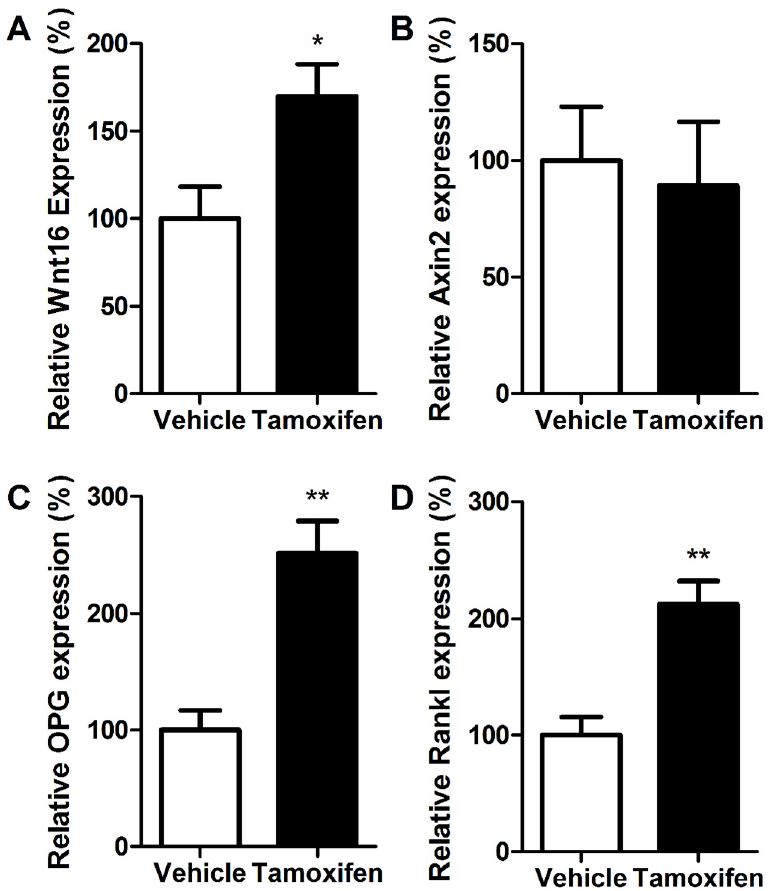
Fig 5. Tamoxifen treatment enhances Wnt16, Opg and Rankl expression in cortical bone of young female mice. (A) Wnt16, (B) Axin2, (C) OPG and (D) RANKL expression was quantified by qRT-PCR in ovariectomized young female mice treated with vehicle or tamoxifen. Bars represent the mean ± SEM. * = p < 0.05, ** = p < 0.01 vs. vehicle, N = 8.